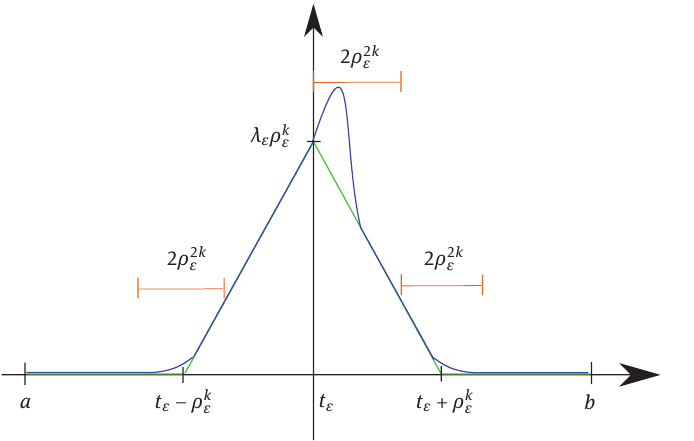
Figure 1: This figure illustrates the function ϑ ε we are considering (blue). The dotted green triangle symbolizes the function which is used in the classical proofs of the Legendre necessary condition (cf. [23, Theorem